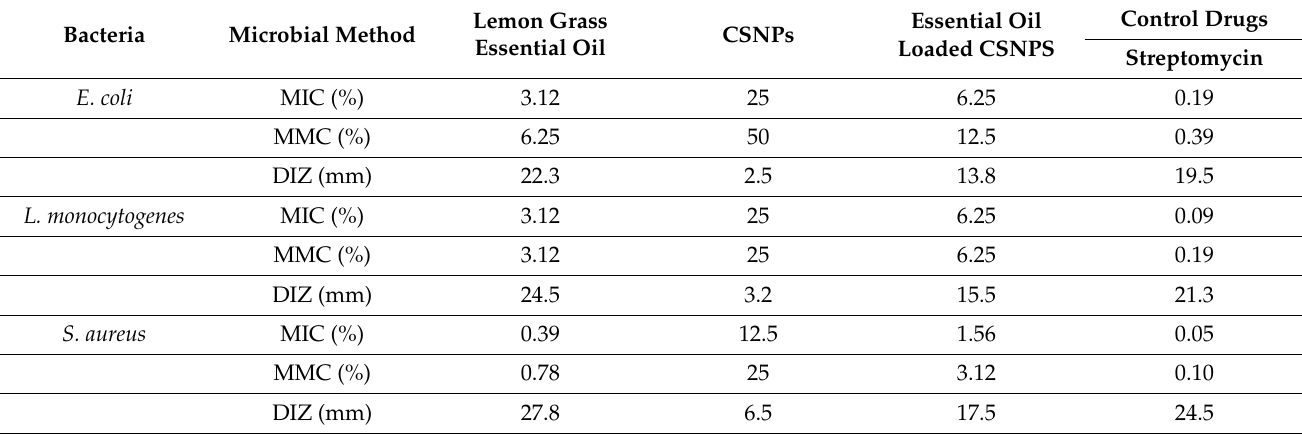
Table 9. Antibacterial evaluation of CSNP nanoencapsulation of lemongrass essential